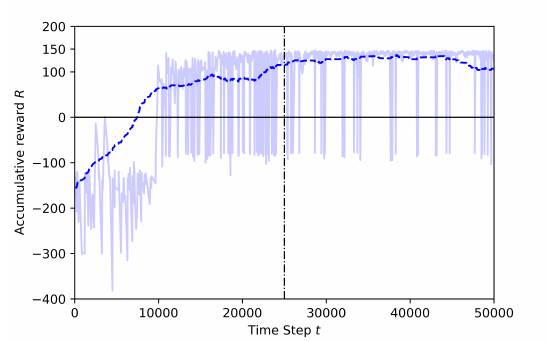
Figure 22. Training result for Case 1.2, Annealing at 25K steps.